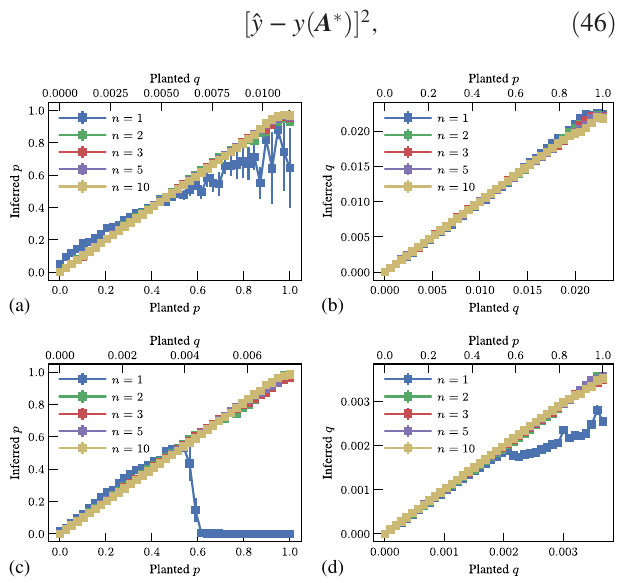
FIG. 5. Inferred values of noise magnitude p and q as a function of the planted values, for the same simulated measurements described in Fig. 4, for political blogs [(a),(b)] and openflights [(c),(d)]